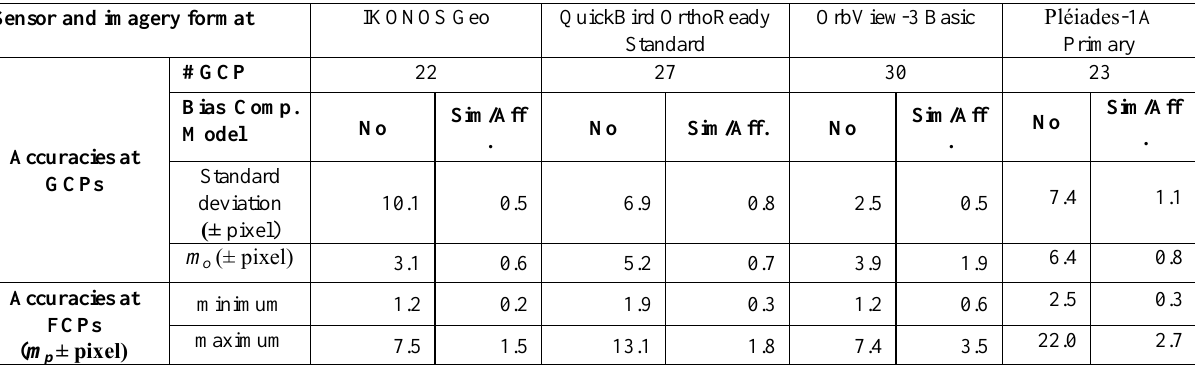
Table 1. Summary of the Accuracies at GCPs and FCPs for 1st Degree RFM (Topan et al.,